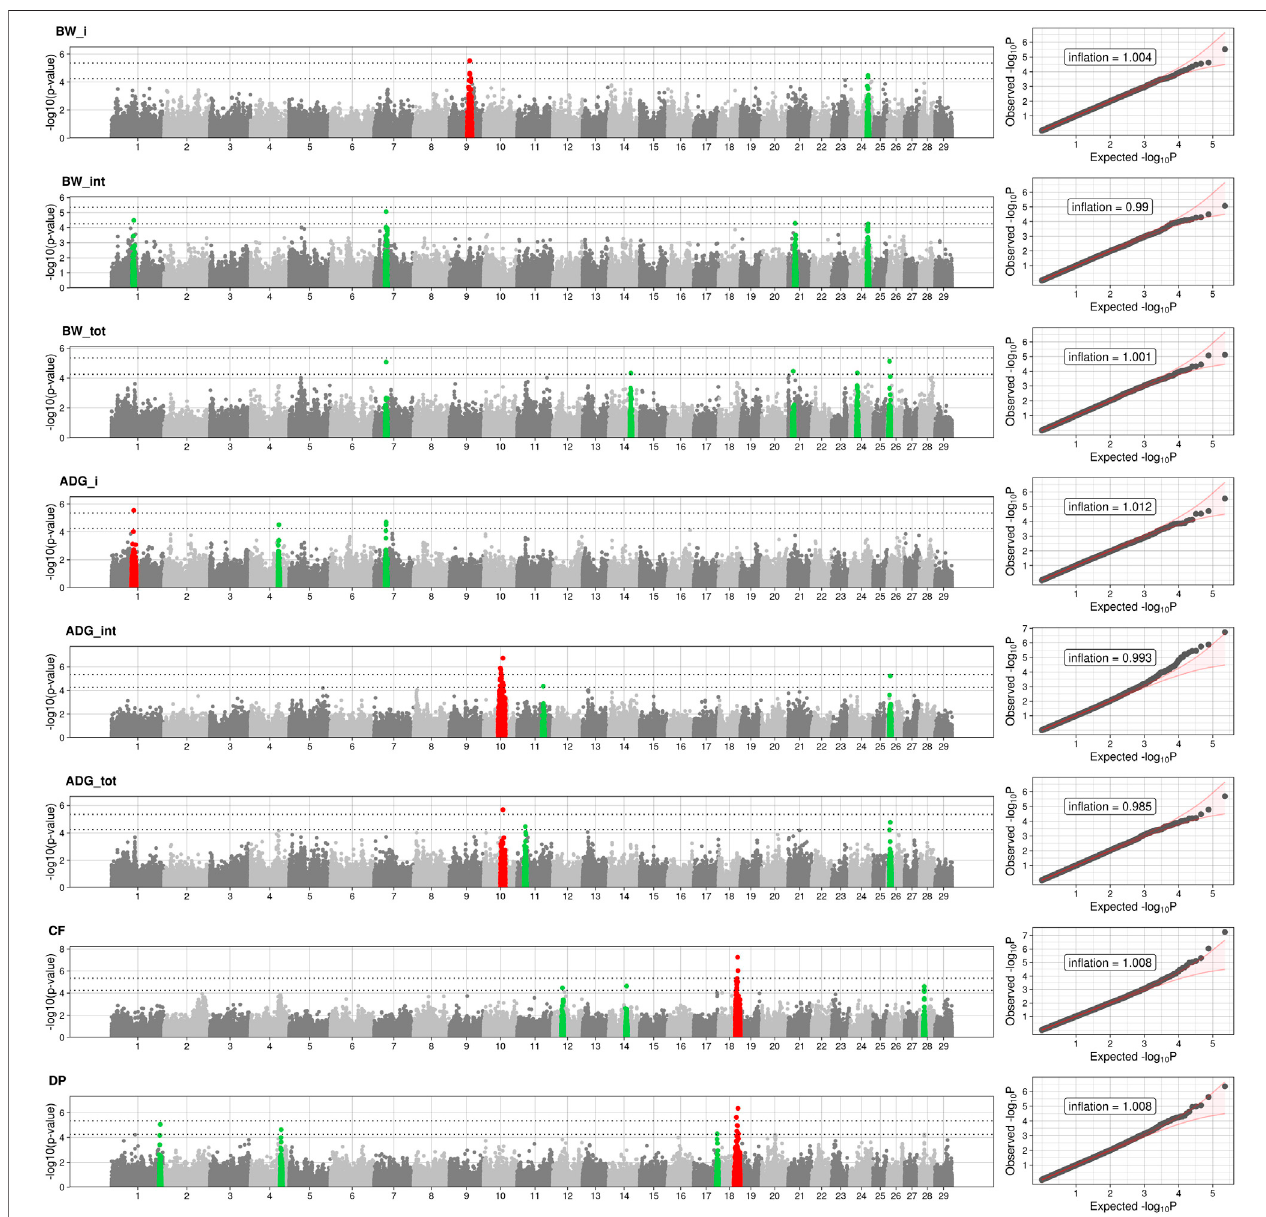
FIGURE 2 | Manhattan and Q-Q plots of BW_i: body weight at the entrance at performance test stations; BW_m: body weight at 6 months; BW_f: body weight at theendofperformancetest.Averagedailygain:ADG_i,coversofthe fi rsthalfoftheperiod(sinceenteringintothePTstationuntilthe6thmonth);ADG_f,coversthedaily gain of the second half (from the 6th month to the end of the period); ADG_tot is the average daily gain throughout the entire period. DP, Dressing Percentage; CF, Carcass Fleshiness. Dotted lines represent the suggestive and the signi fi cant threshold. Red dot represented the signi fi cant SNPs and neighboring SNPs ( ± 1 Mb) while green dot are the SNPs and neighboring SNPs ( ± 1 Mb). Q-Q plots are displayed as scatter plots of observed and expected – log10 ( p -values) (right) . Values of in fl ation are reported within the QQplots.